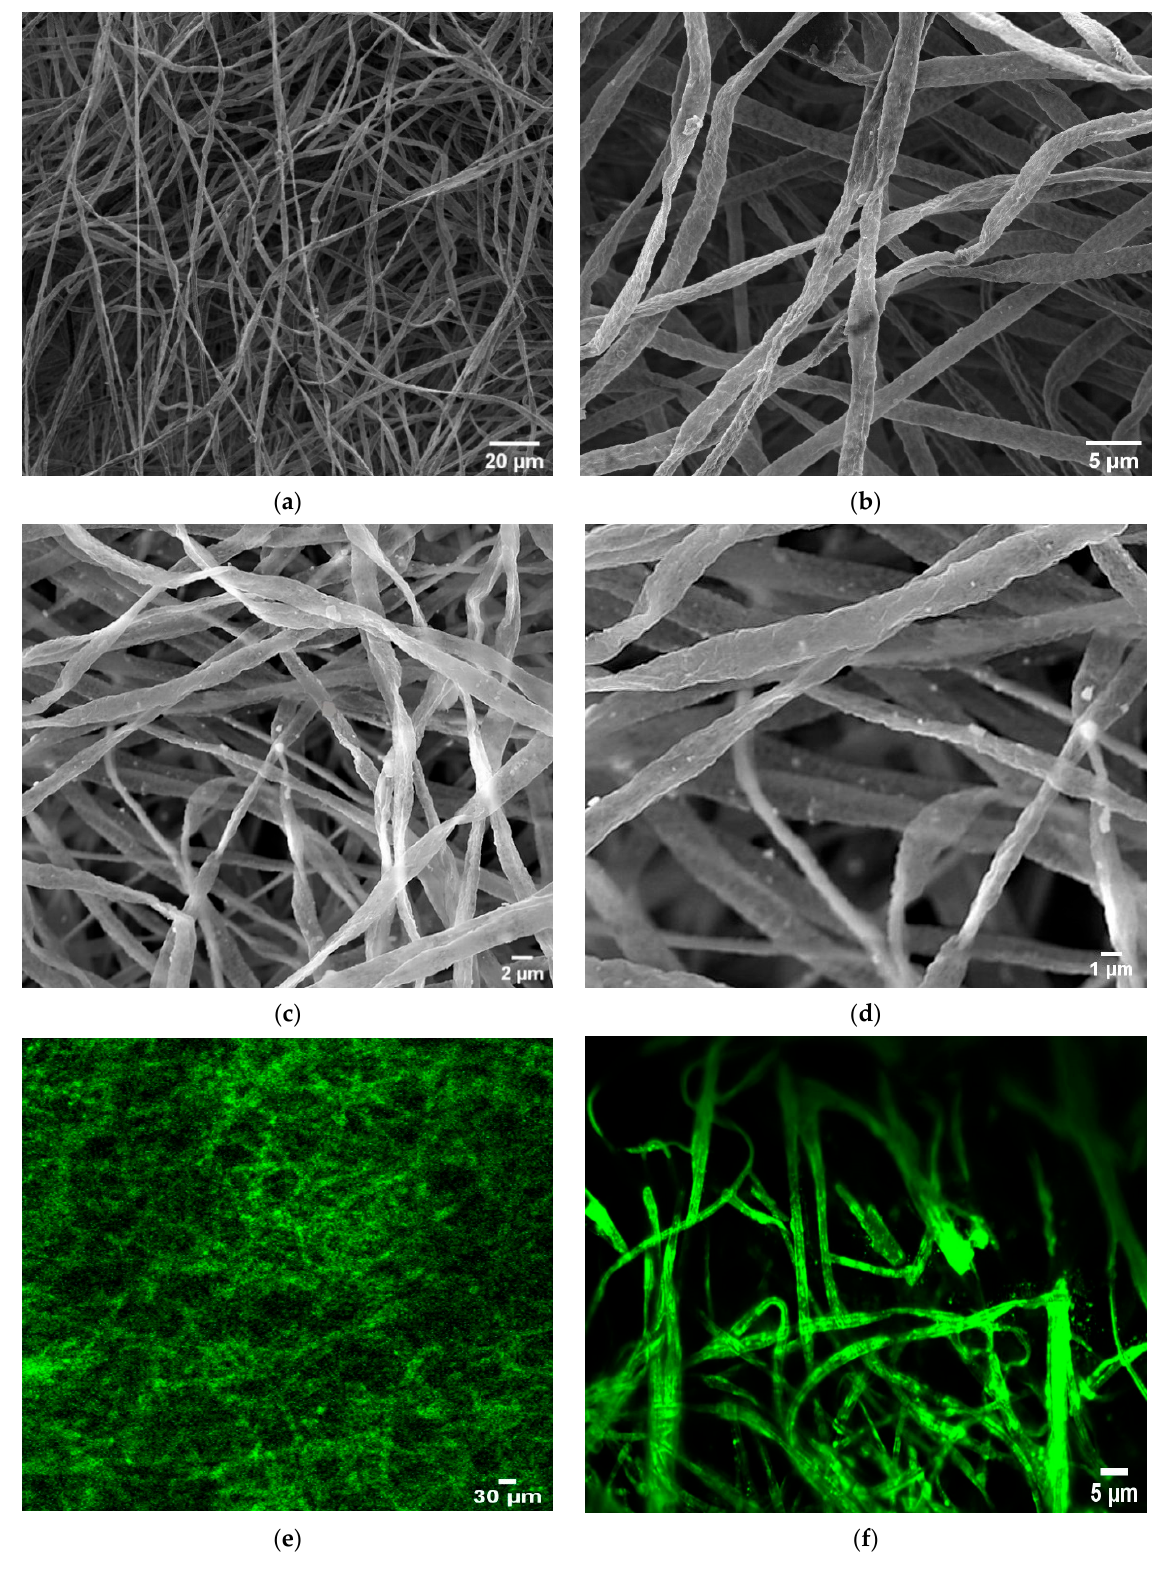
Figure 2. SEM images of the electrospun perovskite-polymer membranes. ( a , b ) Morphology of pristine PLLA nanofibres with different magnifications. ( c , d ) SEM image FAPbBr 3 NCs@PLLA nanofibres ( e , f ) Confocal fluorescence microphotographs of perovskite–polymer membranes with a 488 nm laser as the light source.